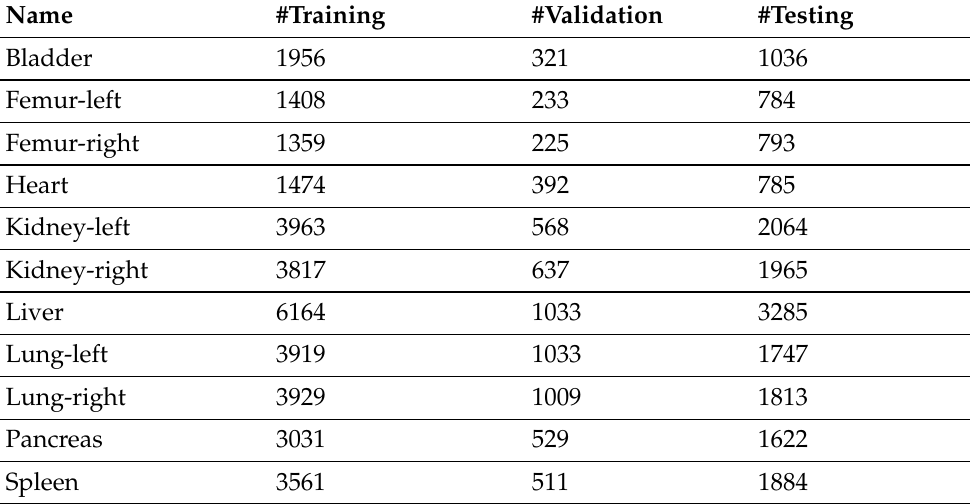
Table 6. Details of OrganMNIST_Axial dataset.